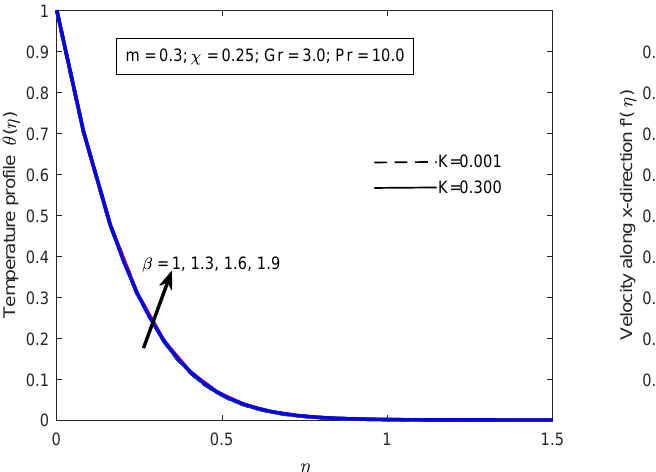
Figure 16: Variation of velocity profile in the x -direction with Prandtl